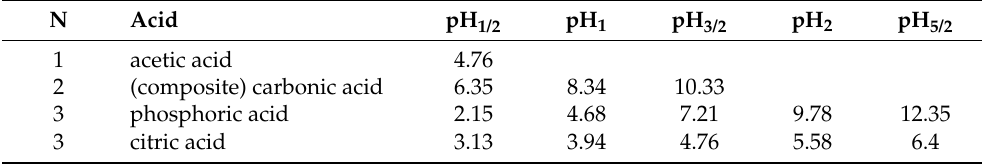
Figure 16. Two approaches to equivalence points. 2.4. Buffer Capacities 2.4.1. ANC and BNC An equilibrium state of the acid–base system with a given amount of C T is fully speci- fied by the parameter C B or n = C B /C T . Buffer capacities are “distances” between two equi- librium states, expressed as the difference/deviation from a reference point: Δ n = n − n ref or